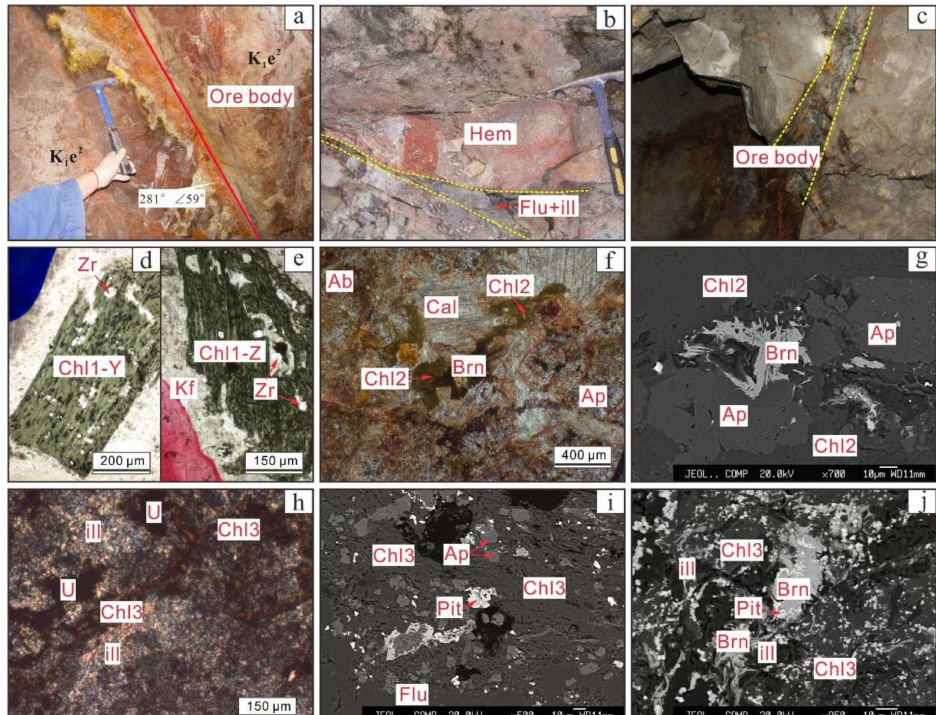
Figure 4. Photographs of typical uranium ore body and micrographs of typical chlorite alteration (Chl1, Chl2 and Chl3) at Zoujiashan and Yunji. ( a ) Alkali metasomatic uranium mineralization (early ore stage) at Yunji deposit, the red line is the fracture; ( b ) alkali metasomatic uranium mineralization (early ore stage) was overprinted with the fluorite-illite alteration (main ore stage) at Zoujishan deposit, the yellow line is the boundary of two styles of alteration; ( c ) typical high grade uranium ore body at Zoujiashan deposit; ( d , e ) biotite replaced by chlorite (Chl1-Y and Chl1-Z) in the weakly altered wall rock; ( f , g ) vein-type Chl2 is intergrown with brannerite or uraninite in alkali metasomatic type ores (Yunji deposit), accompanied by apatite and albite deposition; ( h – j ) disseminated Chl3 are closely associated with uranium minerals, illite, and fluorite (Zoujiashan deposit).